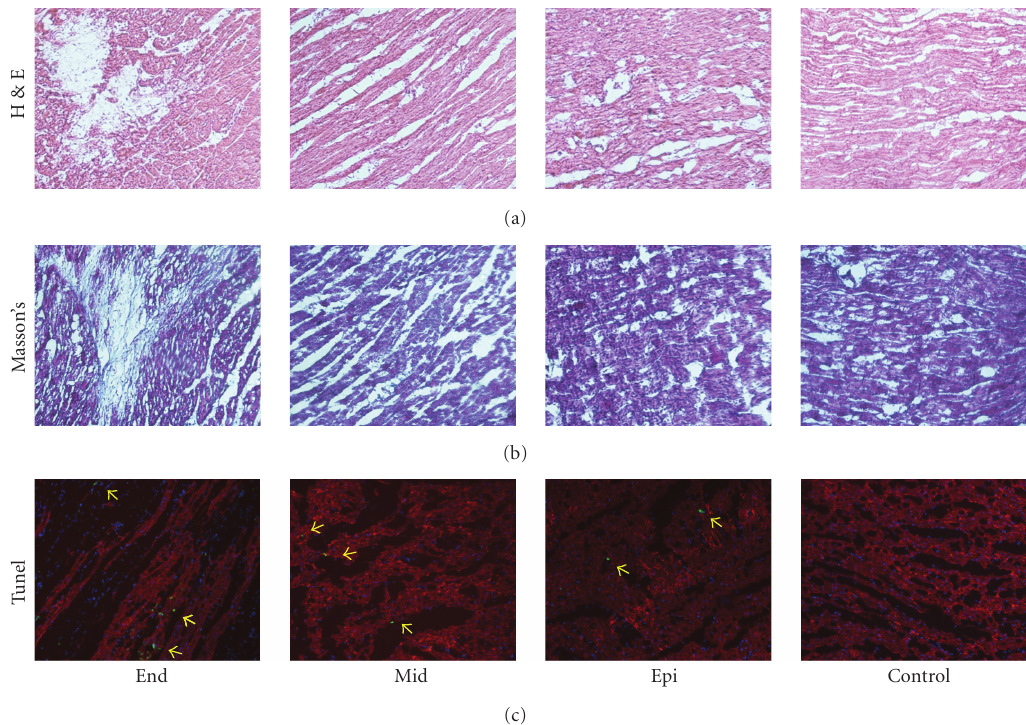
Figure 5: (a, b): General histopathology as assessed by H&E (upper) reveals cardiac lesion. Further characterization by Masson’s trichrome (middle) staining shows interstitial fibrosis, which is more severe towards the subendocardium. (c) TUNEL staining for apoptosis analysis of myocardial tissue sections. TUNEL positive nuclei are stained with FITC (green; arrows). Cardiomyocytes were identified by α actinin immunostaining (red). Nuclei were stained with DAPI (blue). Percentages of TUNEL positive nuclei were 0.40%, 0.26%, 0.12%, and 0.03% for endo, mid, epi, and control endo, respectively. H&E: hematoxylin and eosin, FITC: fluorescein isothiocyanate, DAPI: 4’-6’-diamidino-2-